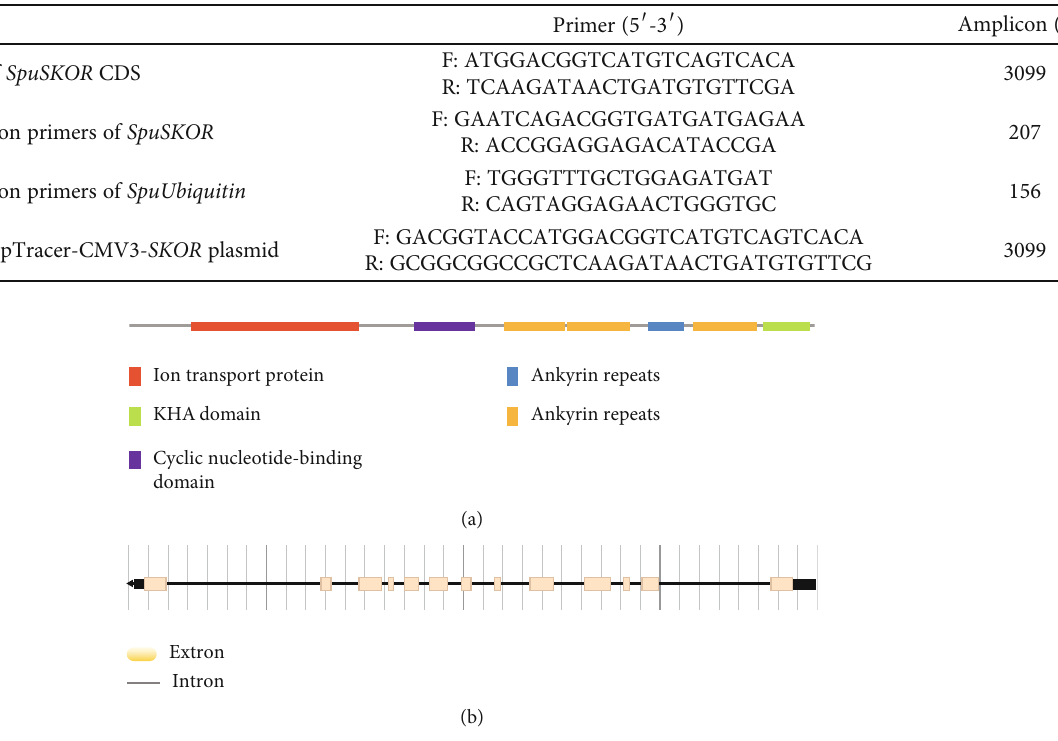
Figure 1: Domain prediction and gene structure analysis. (a) Domain prediction of SpuSKOR protein. (b) Gene structure analysis of SpuSKOR